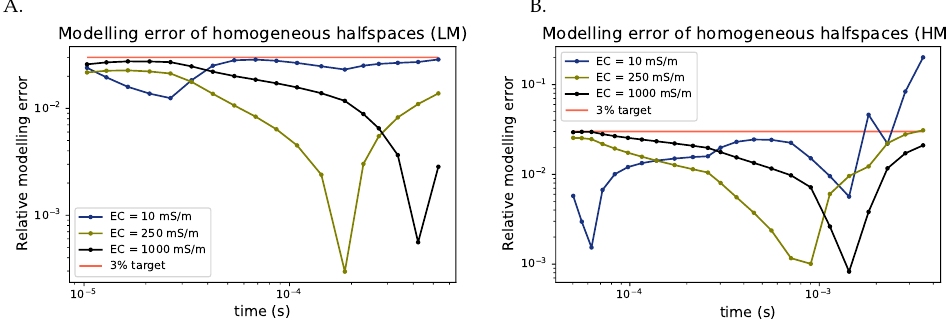
Figure A2. The relative modeling error of a homogeneous halfspace for the dual moment SkyTEM set- up, compared to the semi-analytical forward model for the Low Moment ( A ) and High Moment ( B ). A discrepancy at early time gates indicates that the smallest cell sizes are too